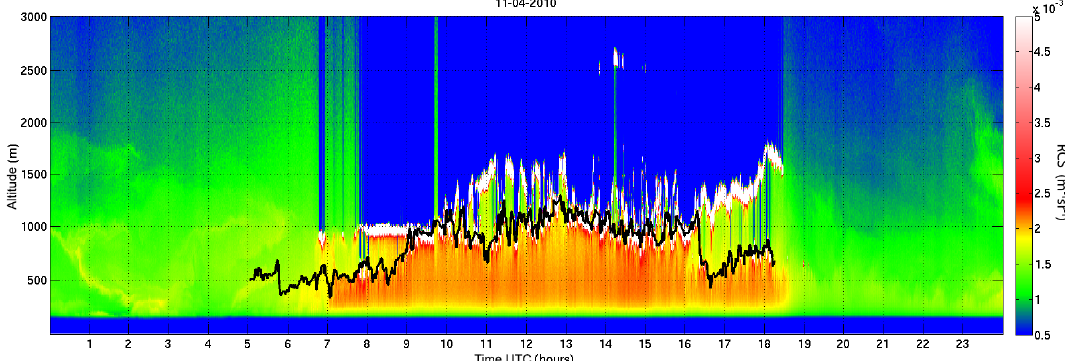
Figure 5. Lidar RCS together with pathfinder MLH estimate on 11 April 2010. A day with cumulus cloud forming on top of the ML with an additional stratocumulus cloud layer above.